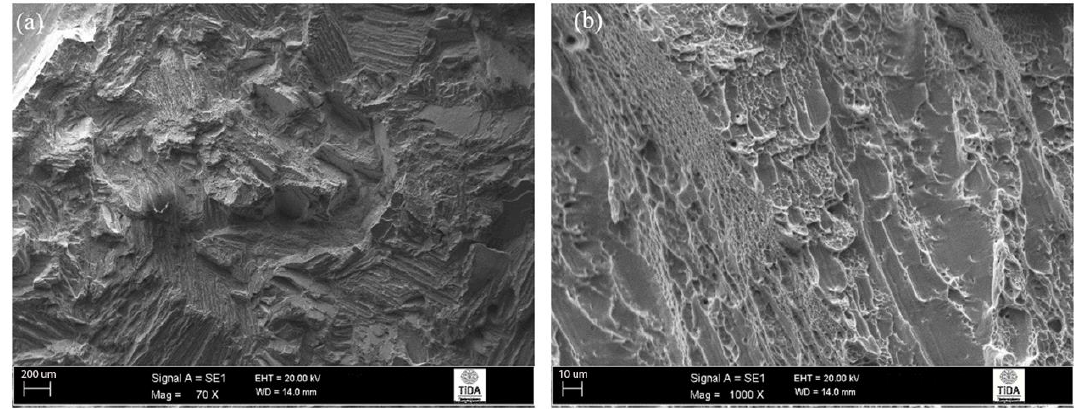
Figure 10. Fracture surface of 1065 ◦ C / 1 h, FC, 730 ◦ C / 2 h heat-treated Ti-6Al-4V alloy: ( a ) transgranular fracture marks; ( b ) signs of ductile fracture.